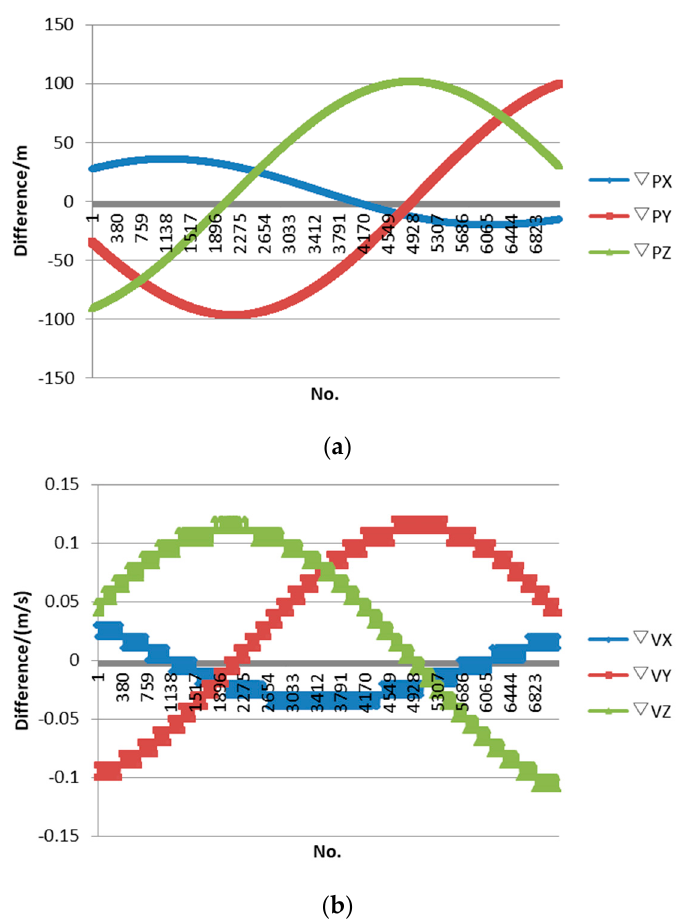
Figure 7. Difference between predicted ephemeris and true ephemeris: ( a ) position difference; and ( b ) velocity difference.